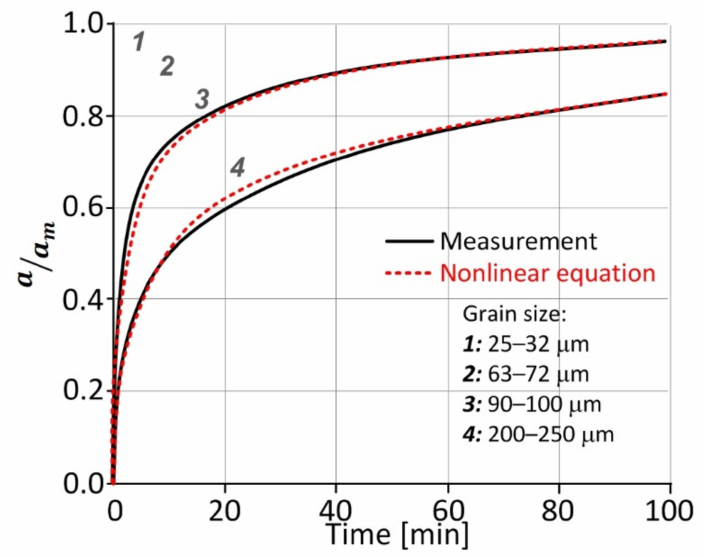
Figure 4. Comparison of the nonlinear solution of the diffusion equation with the experimental results obtained on samples of different grain